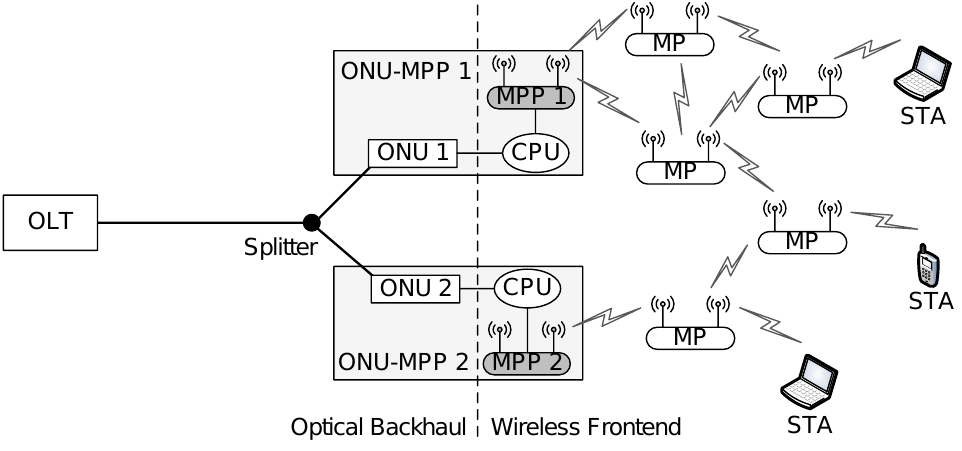
Figure 11. FiWi network interface: integrated EPON and next-generation WLAN-based